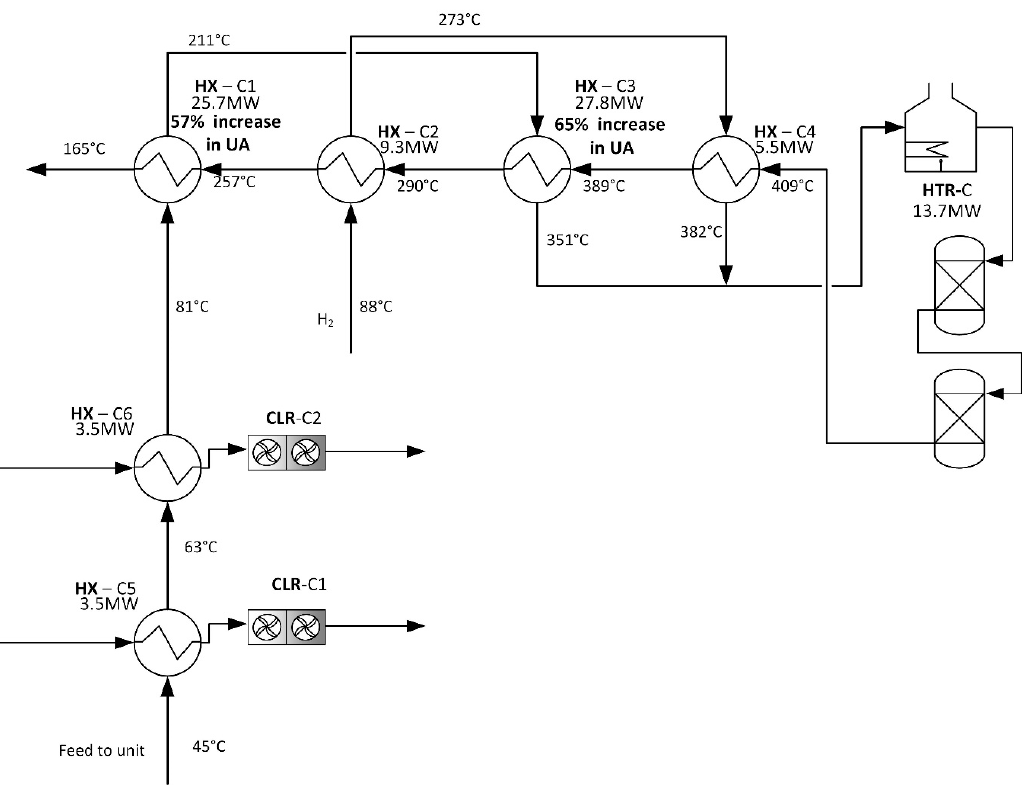
Figure A7. Retrofit proposal 4A.